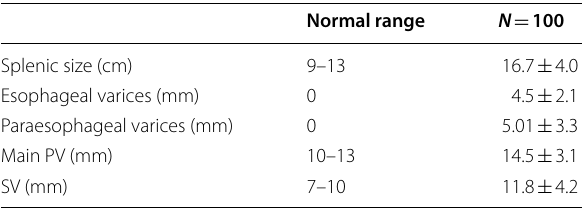
Table 2 Results of MDCT assessment of the size of varices of the study patients ( N =